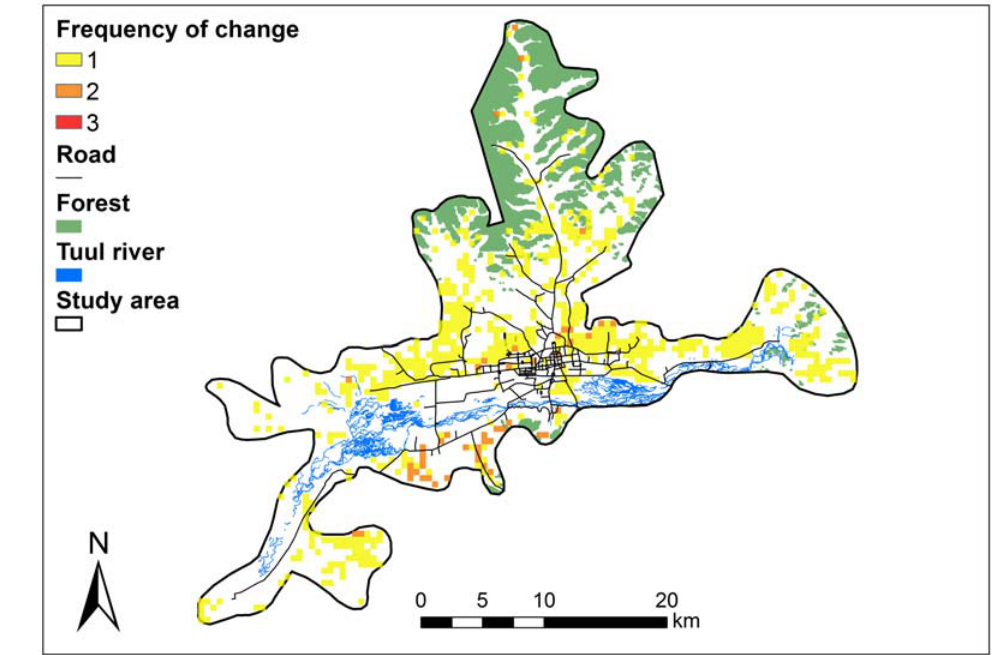
Figure 4. Spatial distribution of the frequency of seasonal component